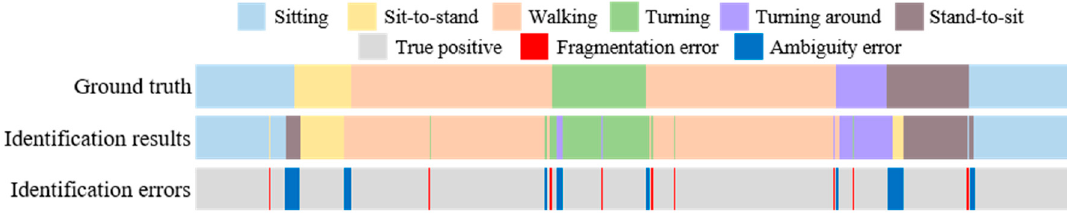
Figure 2. Fragmentation and ambiguity errors in the conventional subtask identification approach.